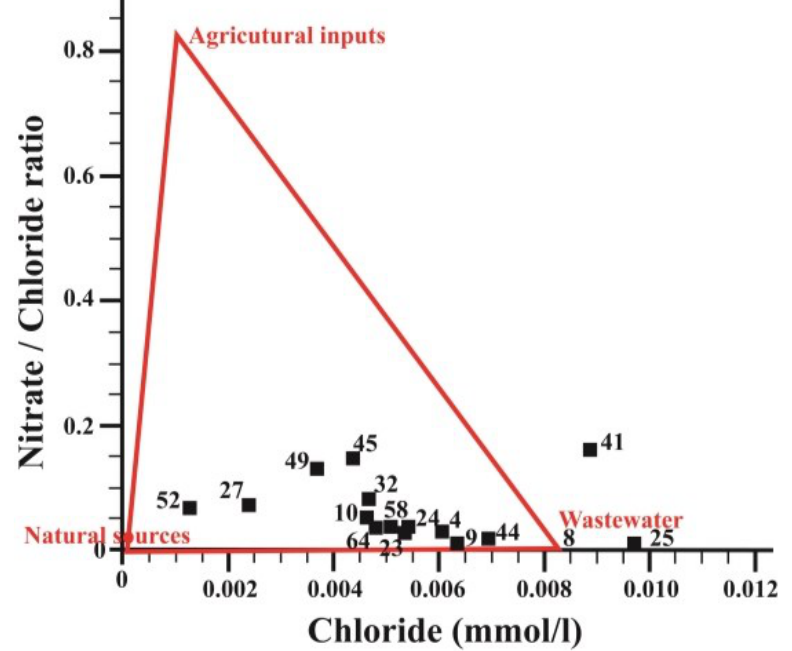
Figure 11. Nitrate-Chloride ratio and chloride concentration in rainy season (modified from [35]).